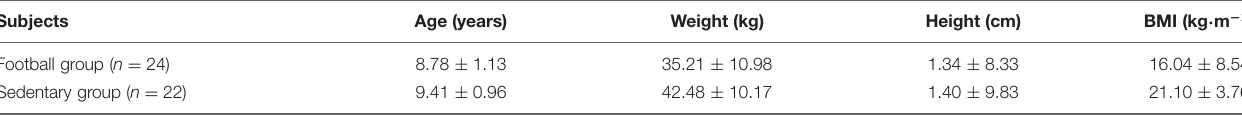
TABLE 1 | Descriptive statistics for age and BMI in the football and sedentary groups.